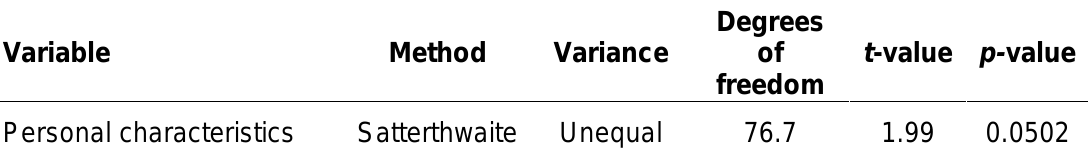
Table 7: Significant Differences Relating to Entrepreneurial Orientation Variable